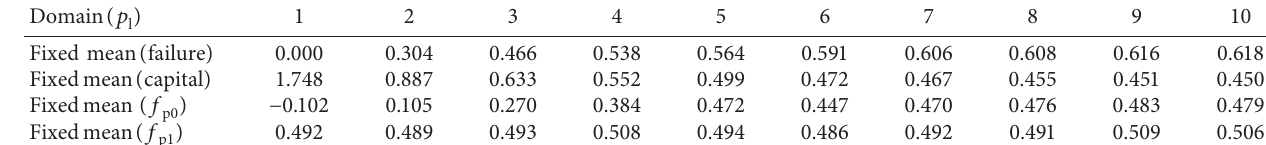
obtained from the Figure 11. l